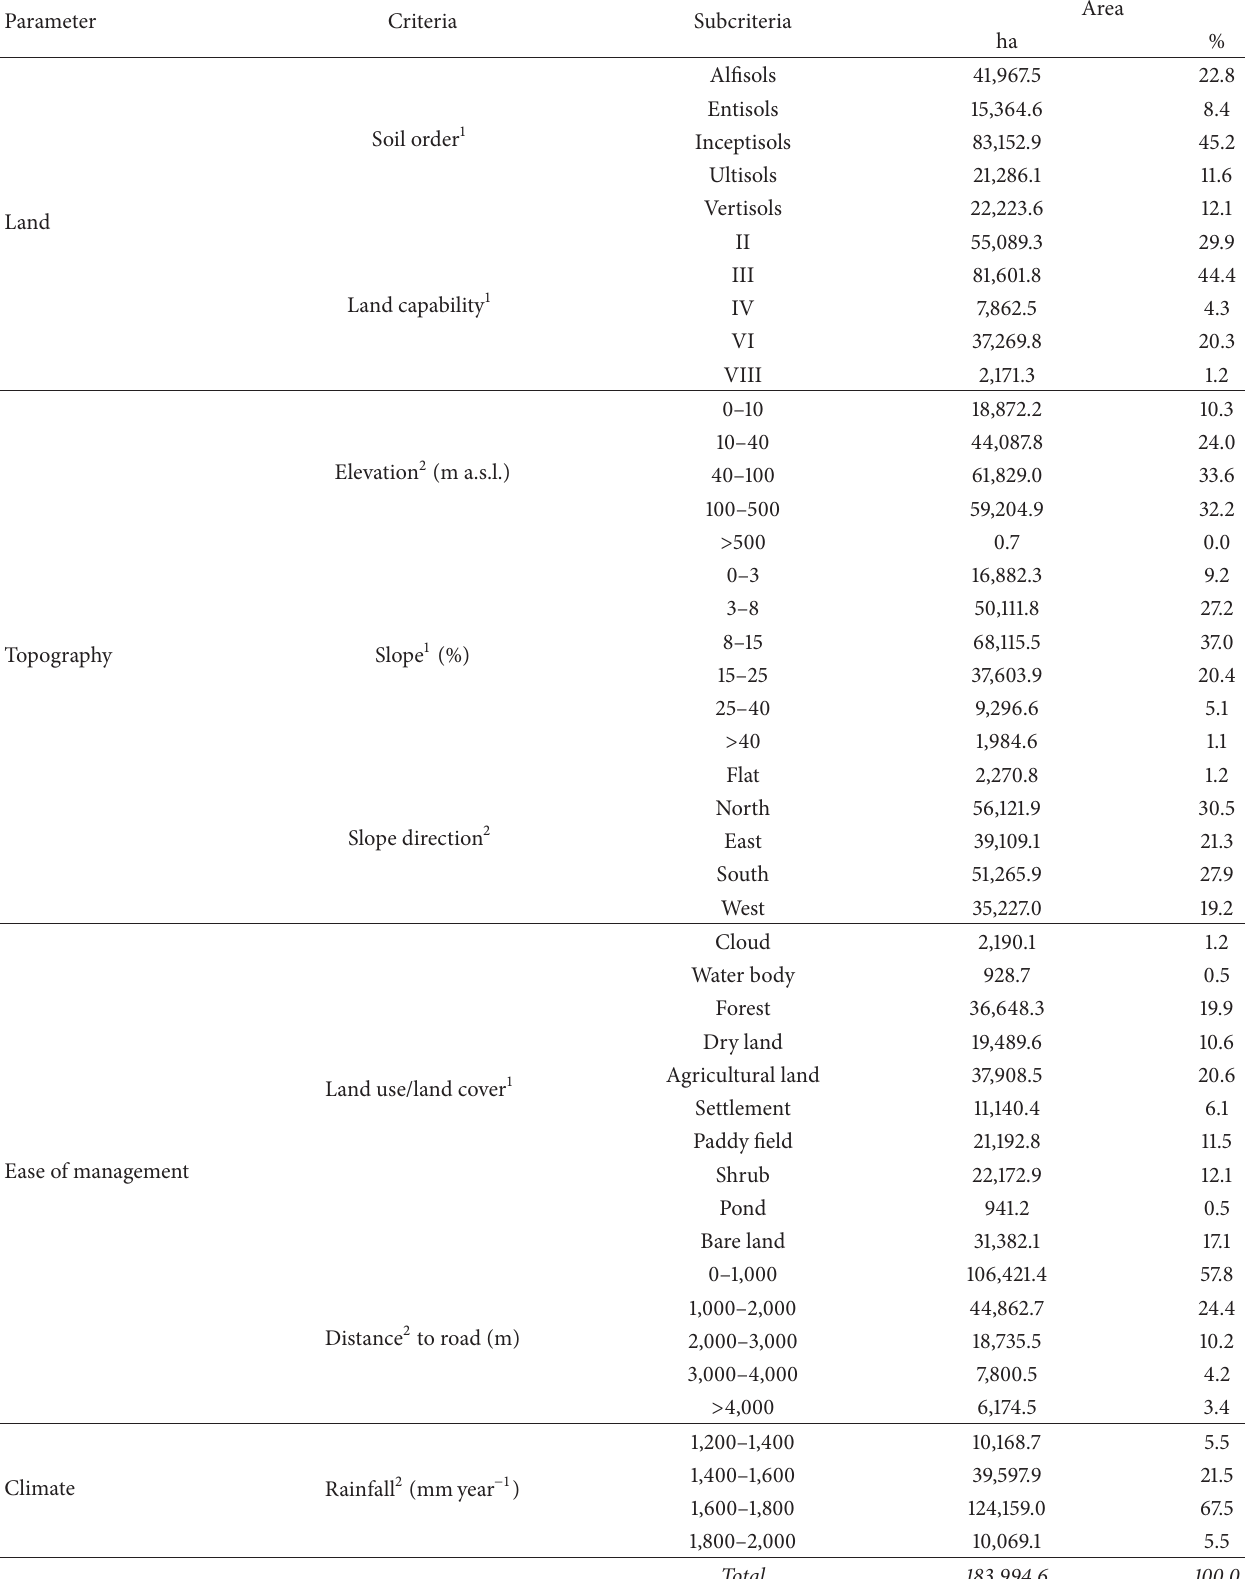
Table 1: Distributions of the criteria and subcriteria in the study area of Tuban